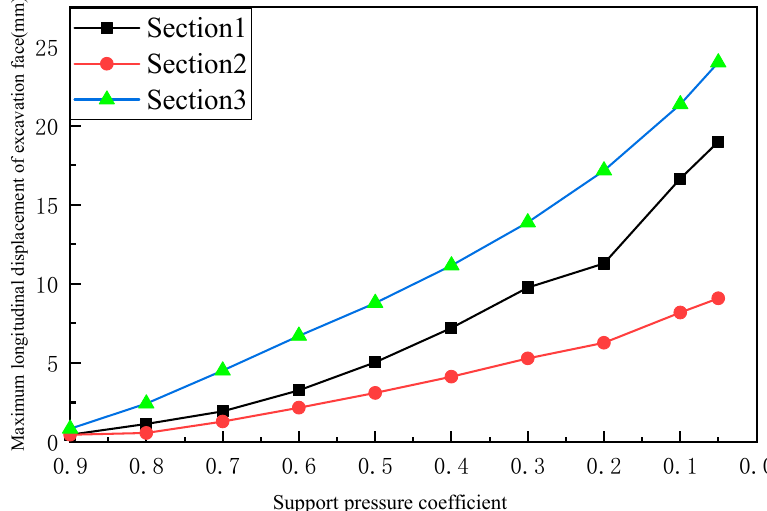
Figure 13. Variation curve of vault vertical displacement of excavation face under di ff erent support pressures.